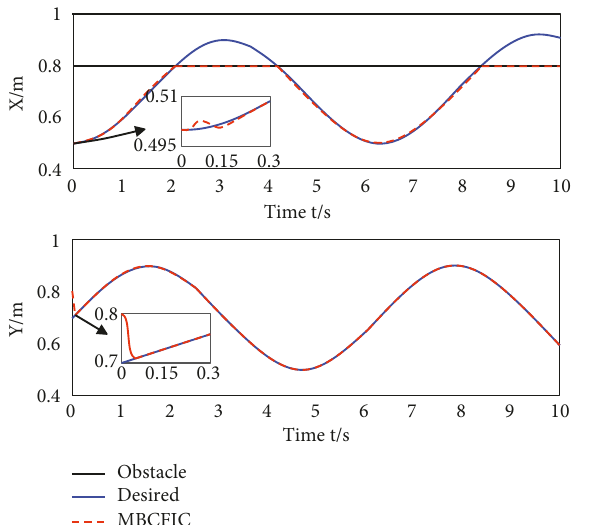
Figure 5: Position tracking curve (the dynamic surface method).